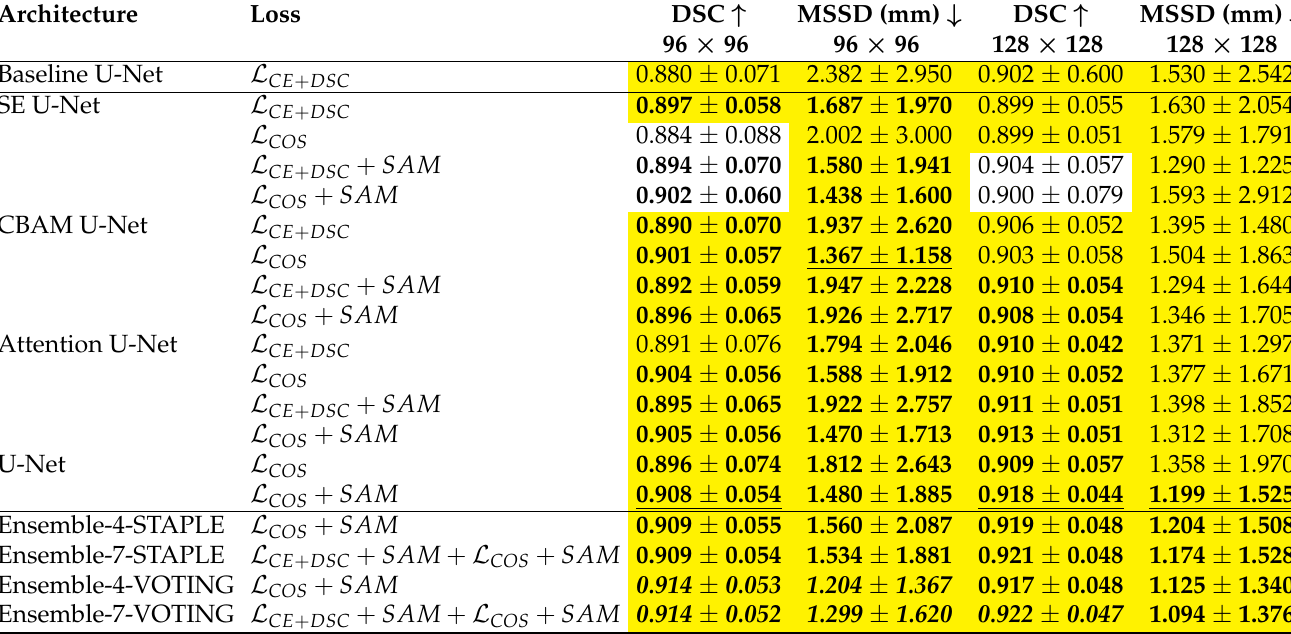
Table 2. Results after post-processing with the largest-connected components. The two evaluation metrics are the DSC and the MSSD with the bold values being significantly better ( p -value < 0.05) than the corresponding baseline network. The underlined values represent the best outcomes in their respective category excluding ensemble results. Meanwhile, the highlighted values in yellow imply a significantly better ( p -value < 0.05) score than the results from the corresponding networks without post-processing from Table 1. The ensembles in italics signify significantly better results ( p -value < 0.05) than the corresponding best performing